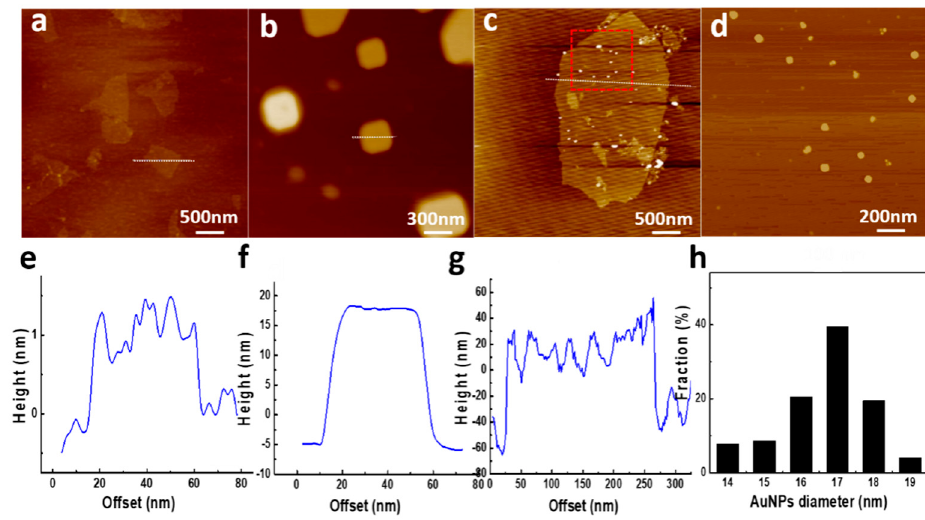
Figure 7. The AFM height images and corresponding section analysis of ( a ) GO, ( b ) BSA immobilized on GO, and ( c ) GO–BSA–Au, as well as their extracted line profiles of ( a ) GO, ( b ) BSA immobilized on GO, and ( c ) GO–BSA–Au, respectively. ( d ) AuNPs immobilized on the GO–BSA membrane. ( e ) Height image of extracted line profiles in ( a ) GO. ( f ) Height image of extracted line profiles in ( b ) BSA immobilized on GO. ( g ) Magnified height image of the red square area in ( c ), showing the AuNPs immobilized on the GO–BSA membrane. ( h ) The size distribution of AuNPs.